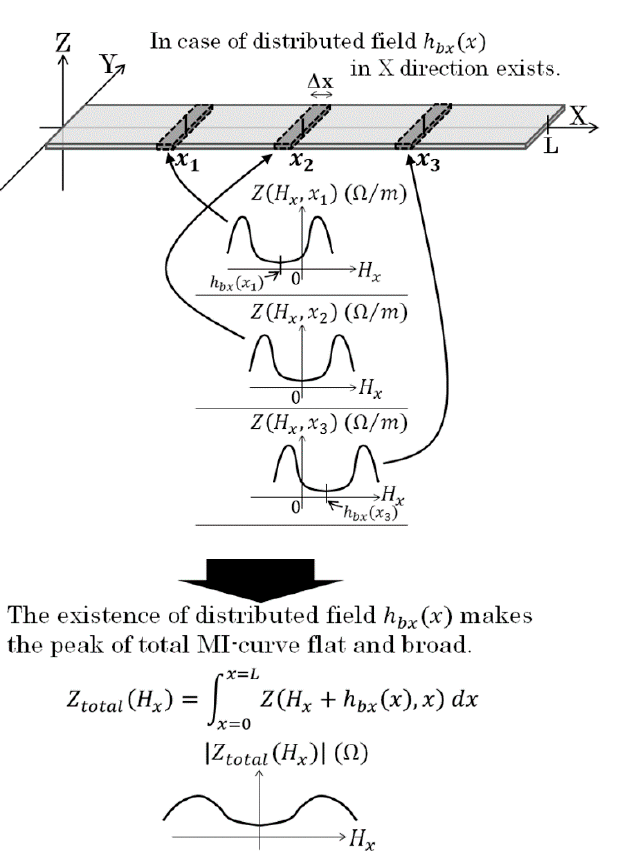
Figure 15. Schematic explanation of a distributed vertical magnetic field [21].